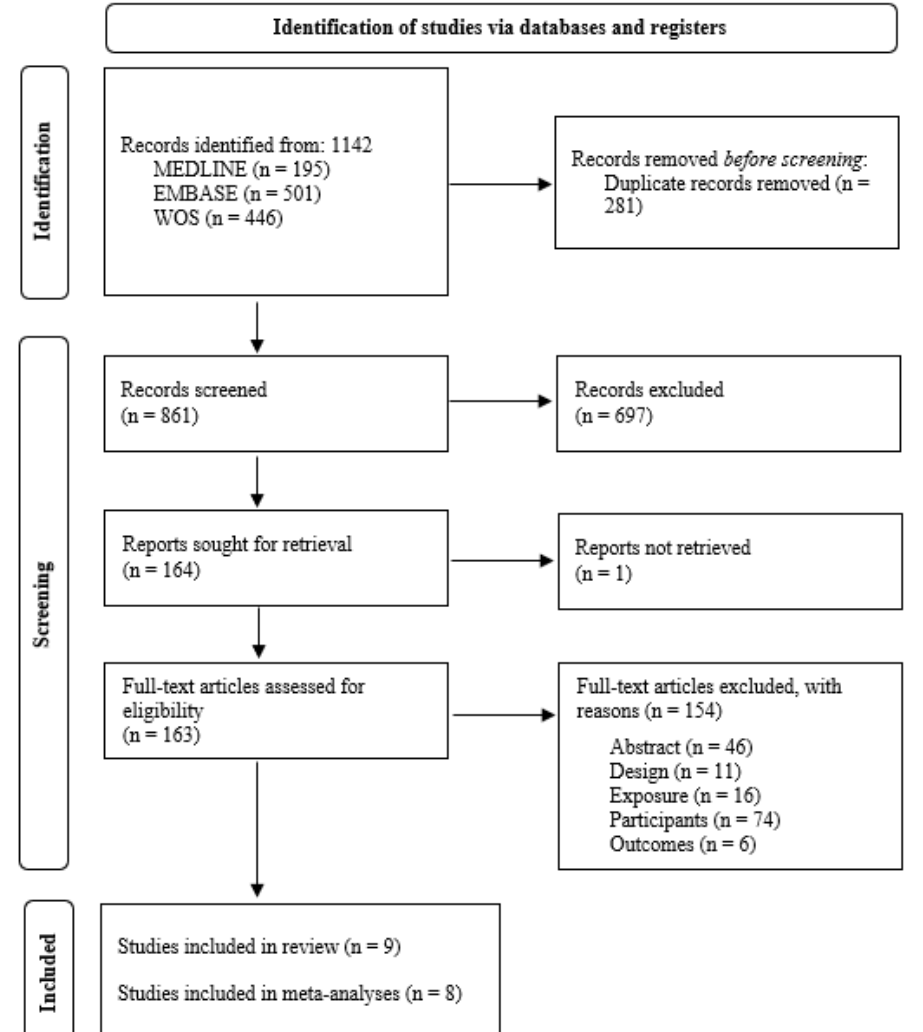
Figure 1. PRISMA flow chart detailing the screening process.